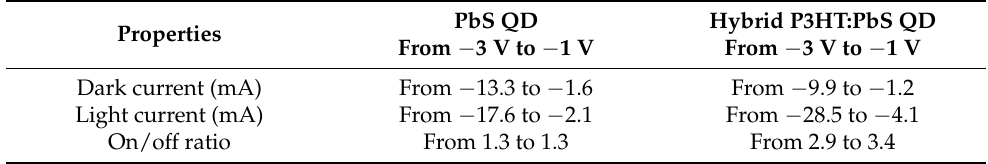
Table 1. The results of the measured devices.